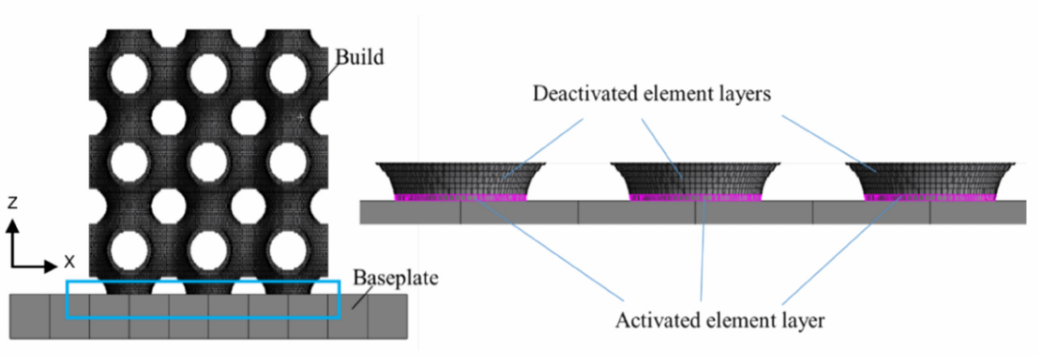
Figure 5. The illustration shows the activation of the first layer of elements (highlighted in purple color) for deposition; the rest of the layers above are in the deactivated state representing the material to be deposited.